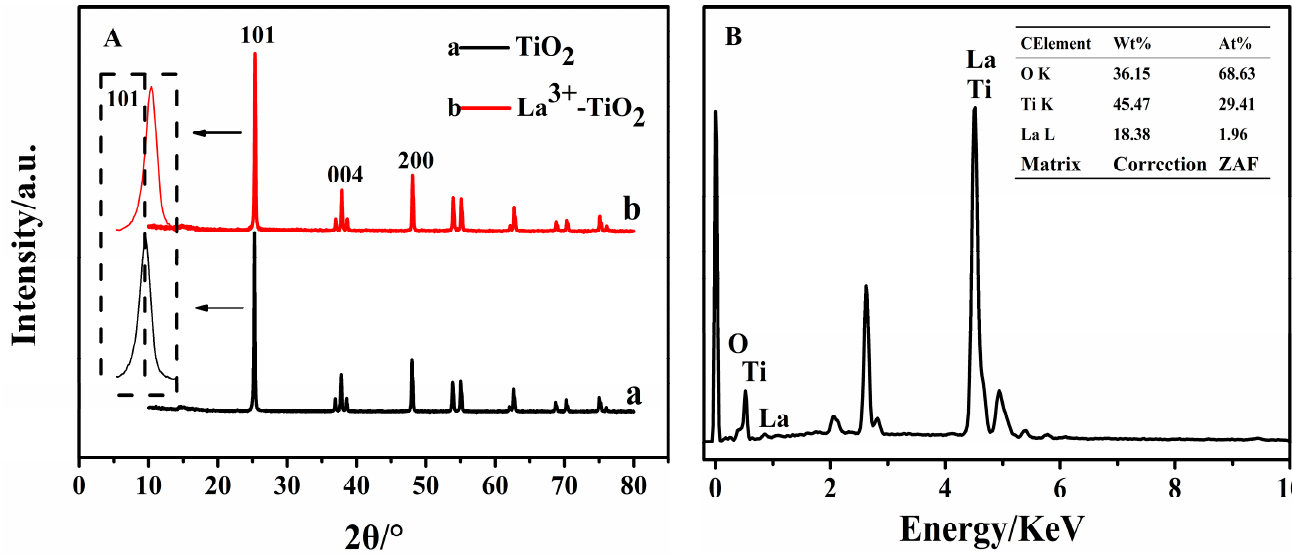
Figure 2. Characterization of the La 3+ /TiO 2 . ( A ) XRD pattern; ( B ) EDX spectra and component molar ratio.